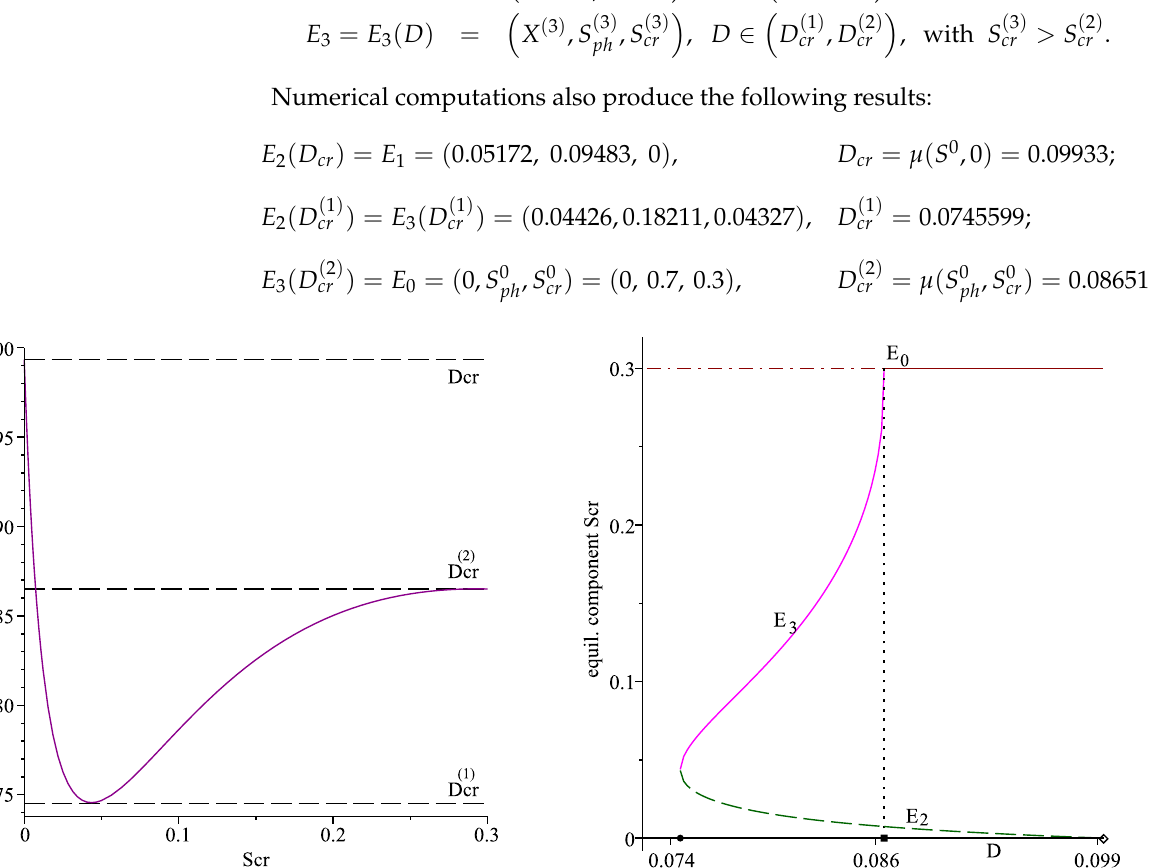
Figure 1. ( Left ): graph of the function µ ( S 0 + KS cr , S cr ) for S cr ∈ [ 0, S 0 cr ] . ( Right ): the equilibrium components S ( 3 ) line) and S cr (solid line), parameterized on D . The horizontal dash-dot&solid line passes trough S ( 1 ) ( 2 ) the solid circle denotes D cr , the solid box denotes D cr , the diamond denotes D cr . The vertical dot line passes through D Figure 1 (right plot) and Figure 2 visualize the components S cr , S ph and X of the equilibria E 0 , E 2 and E 3 . In the three plots, the components of the equilibrium point E 0 are marked by horizontal dash-dot&solid lines, the components of E 2 are marked by dash lines and the ones of E 3 are shown by solid